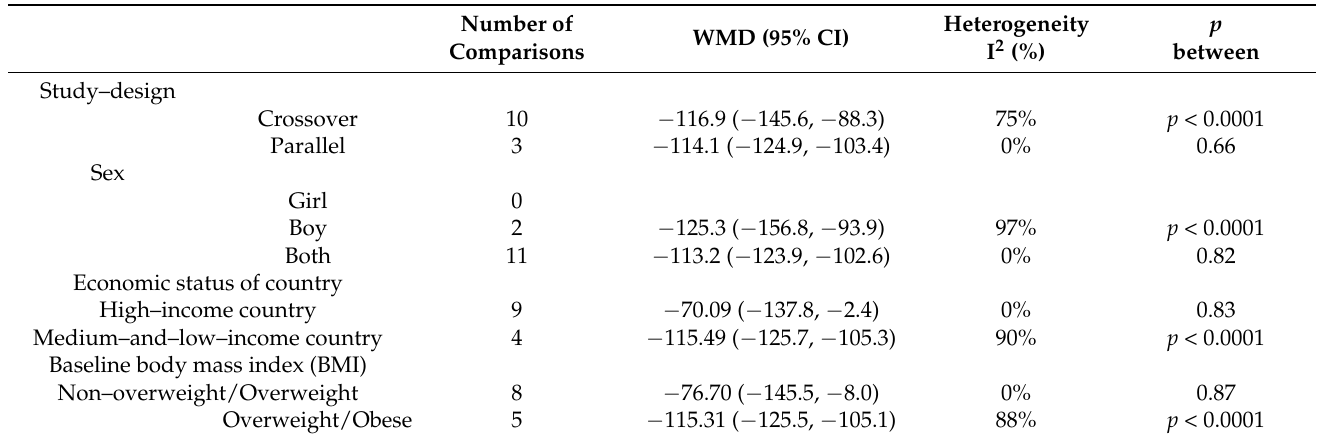
Table 5. Results of subgroup–analysis for subsequent energy intake (kcal) and protein–rich